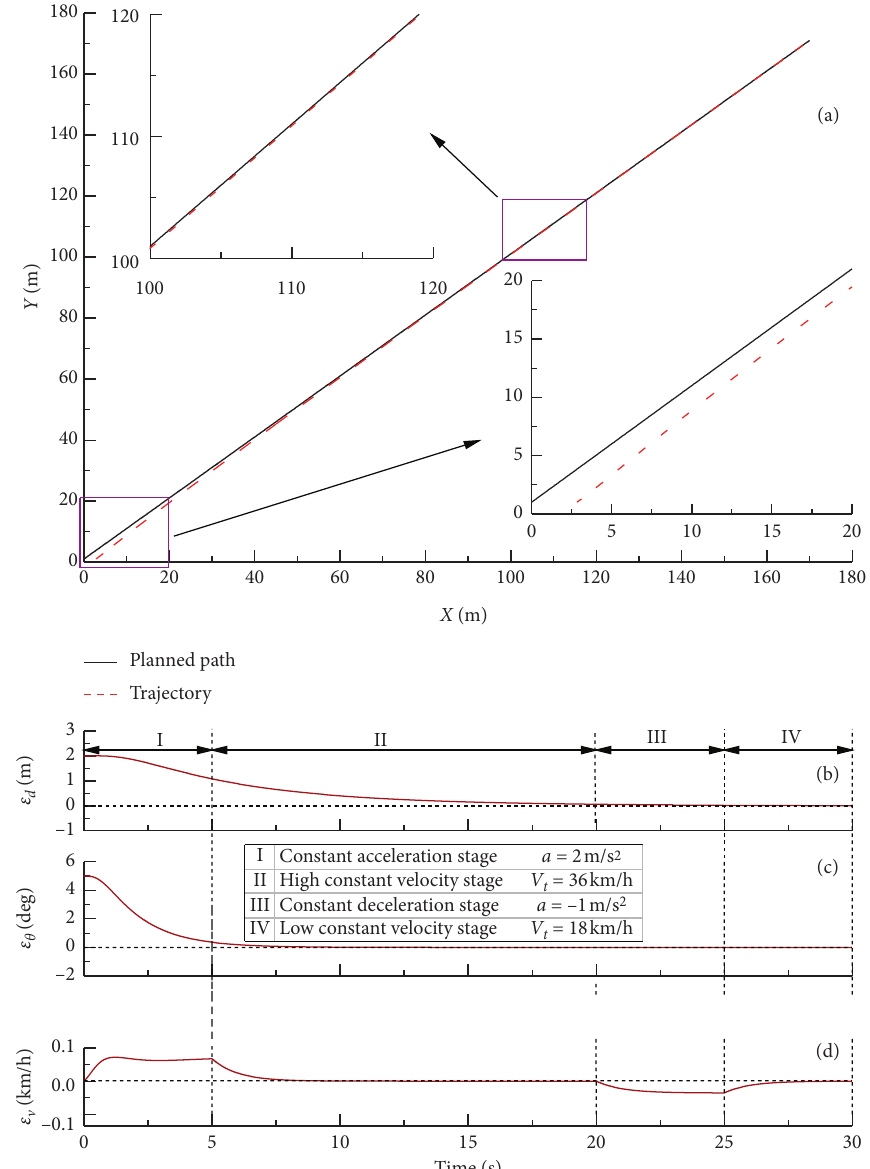
Figure 5: The control performances of the vehicle in the straight path-following